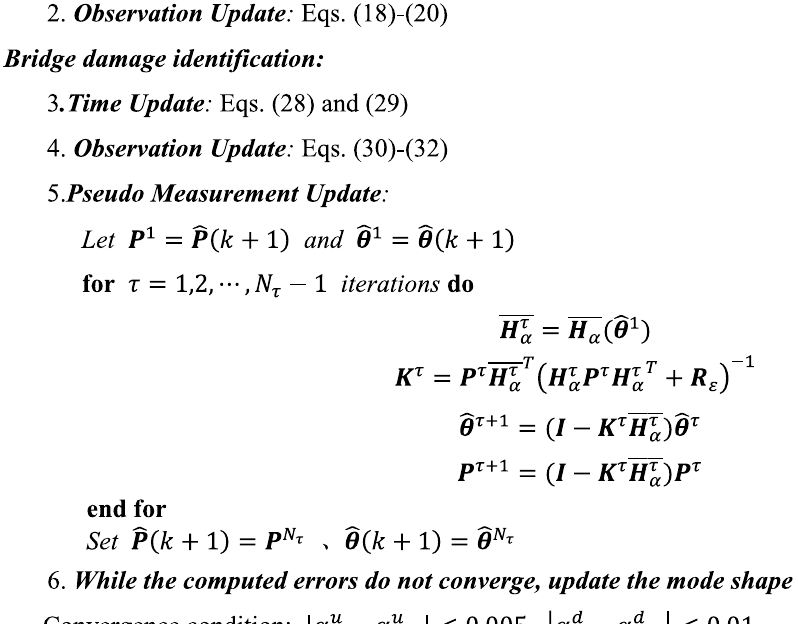
Table 1. In this paper, the EKF of linearization method is used to deal with nonlinear models. In order to improve the